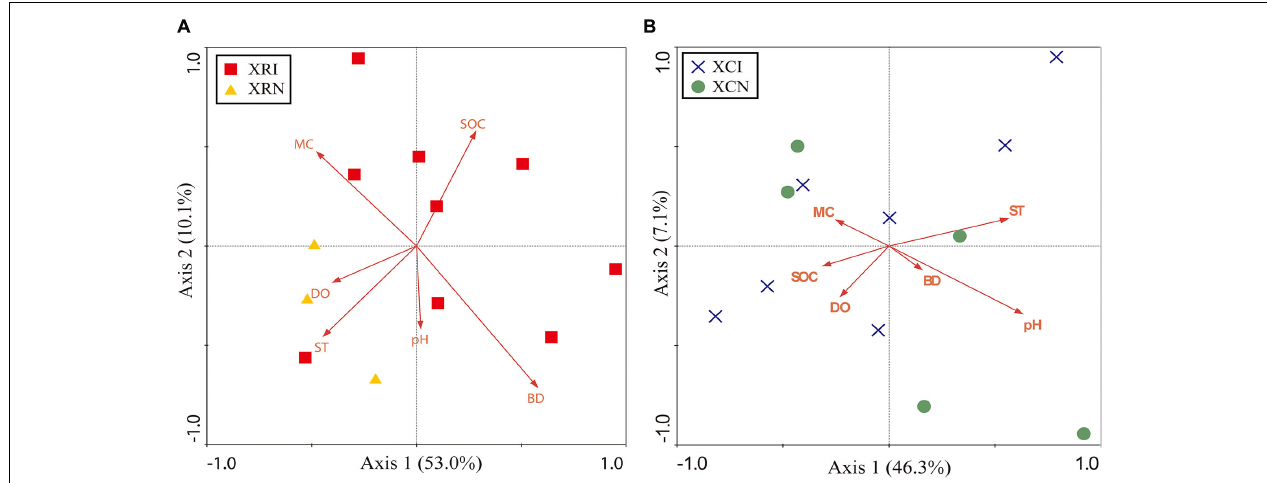
FIGURE 6 | Redundancy analysis (RDA) diagram illustrating the relationship between soil physicochemical properties and the soil bacterial community in XR (A) and XC (B) . In XR, Axis 1 explained the maximum variation at 53.0%, and Axis 2 explained 10.1% (A) . Axis 1 in XC explained the maximum variation at 46.3%, and Axis 2 explained 7.1% (B) . Points represent the soil samples. XRI, Xinxue River invaded sites; XRN, Xinxue River non-invaded sites; XCI, Xinxue River Constructed Wetland invaded sites; XCN, Xinxue River Constructed Wetland non-invaded sites. Red arrows represent the soil physicochemical properties: pH, SOC, soil organic carbon content; SOCD, soil organic carbon density; MC, moisture content; BD, bulk density; DO, dissolved oxygen; ST, soil temperature.